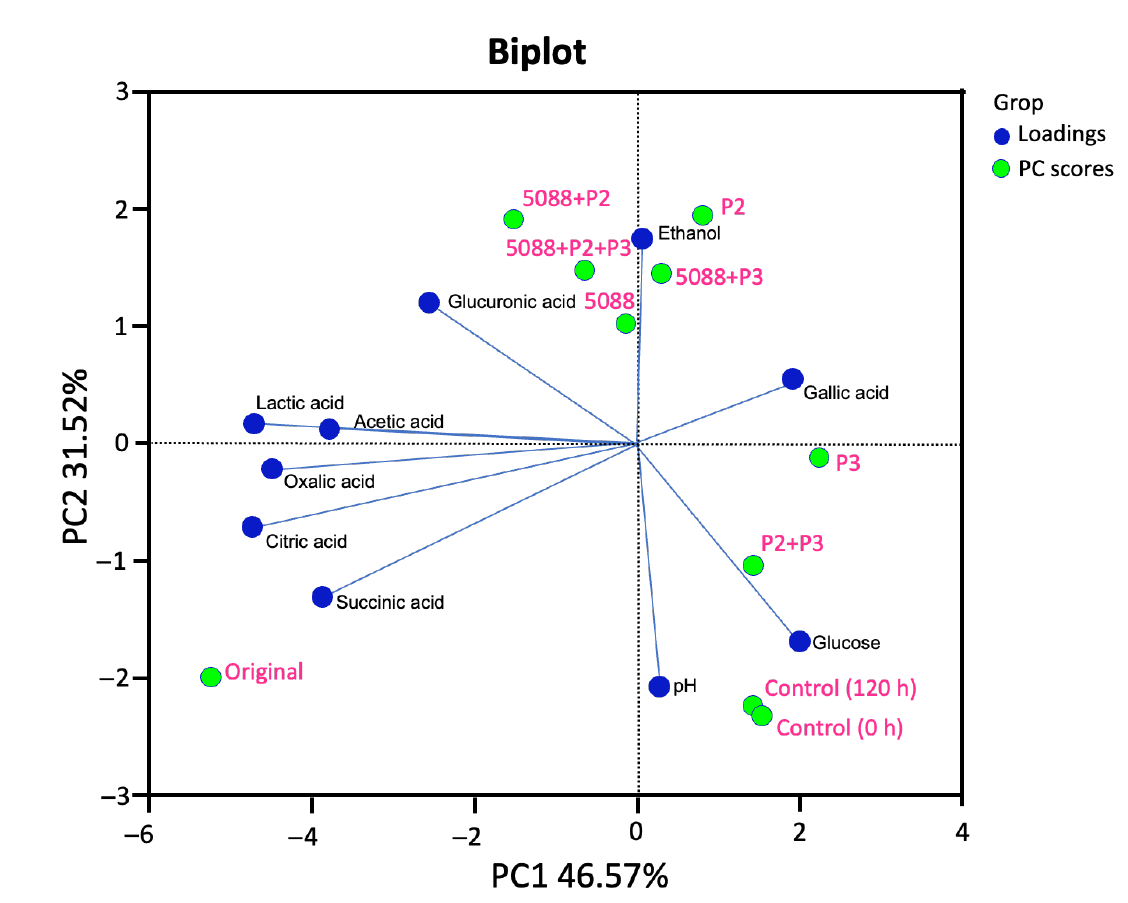
Figure 7. PCA biplot of the organic acids, glucose, ethanol, and pH variables in the original and fermented MF-broth by S. cerevisiae TISTR 5088, W. anomalus P2 and C. rhodanensis P3, with single